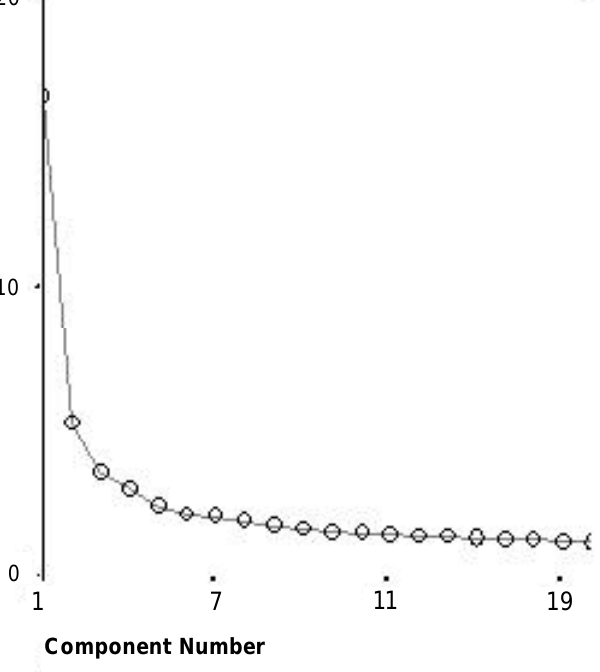
Figura 1. Scree plot da